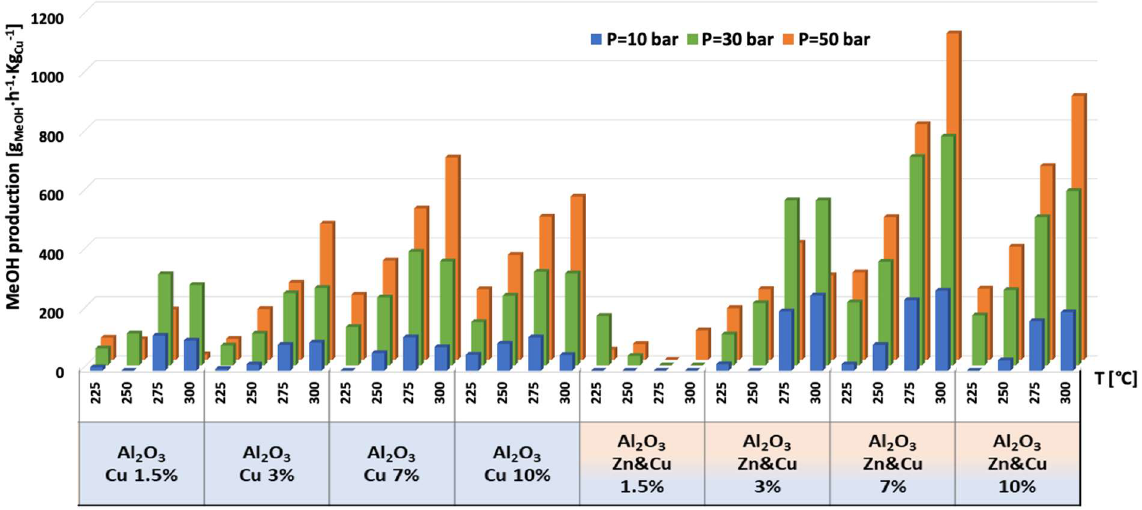
Figure 10. Production of DME per gram of Cu for AlNFs-Cu and AlNFs-1Cu2.3Zn catalysts at pres- sures of 10, 30, and 50 bar and temperatures of 225, 250, 275, and 300 °C.